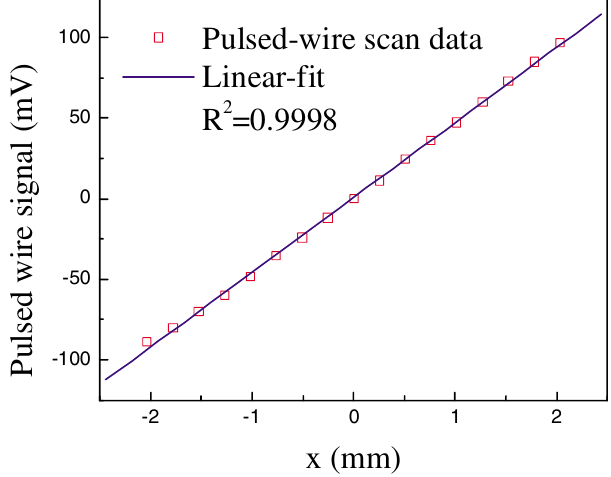
FIG. 16. (Color) Field linearity scan over accessible PMQ aper- ture from pulsed-wire